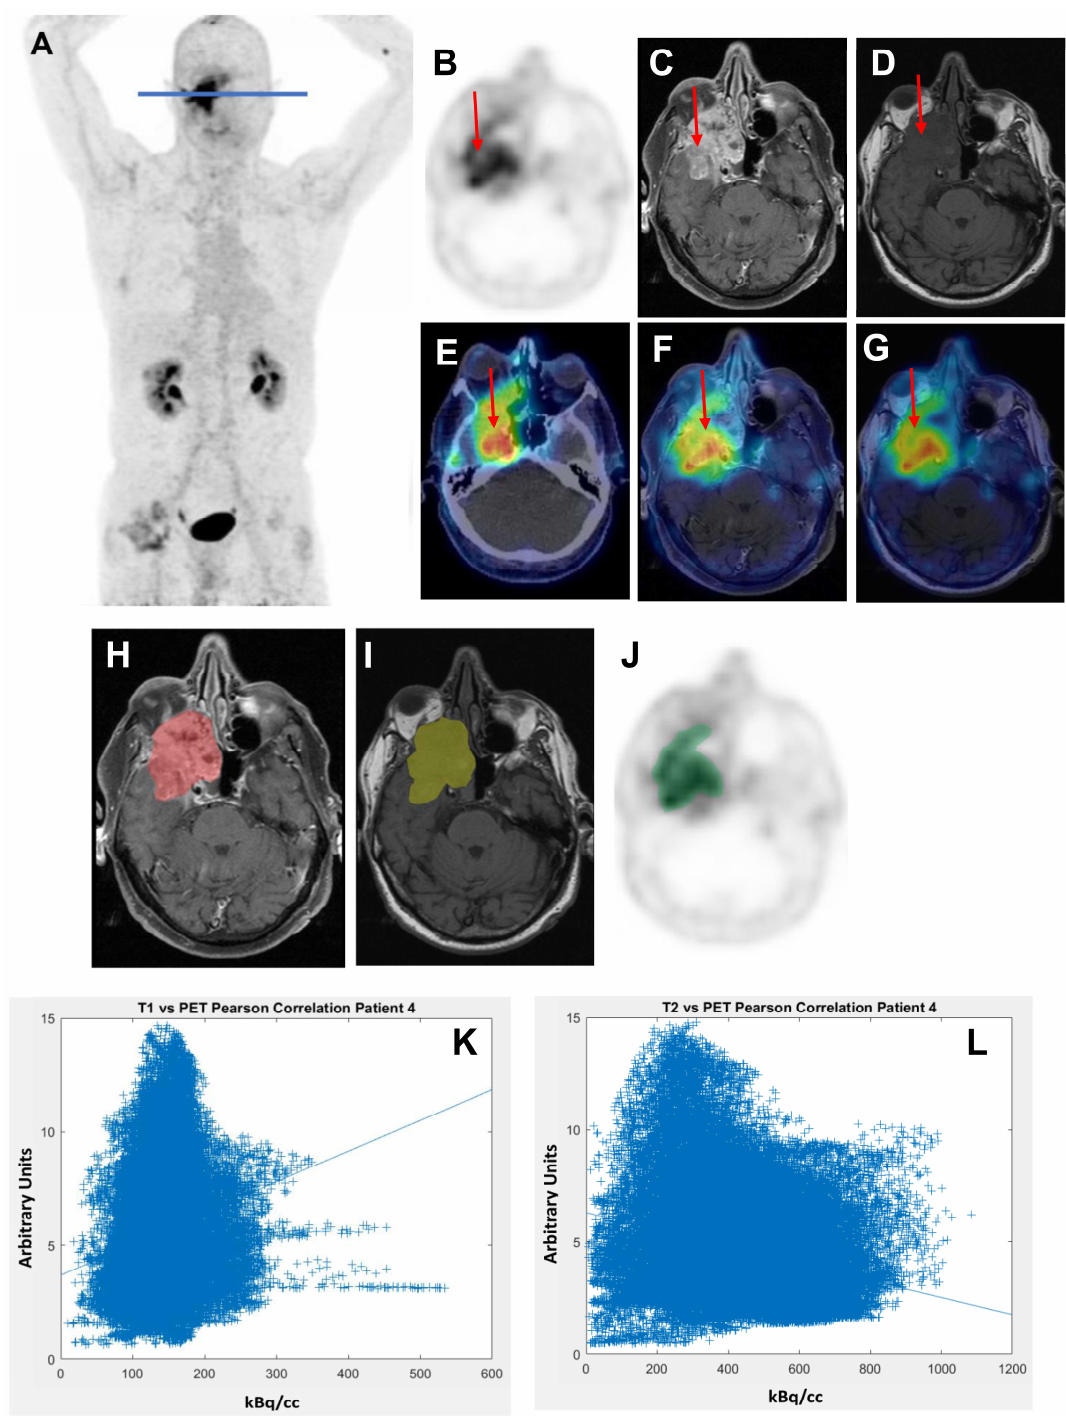
Figure 2. Example (Patient number 4) of a treatment-naïve ACC (tubular type) in the right nasal sinus. ( A ): Maximum Intensity Projection (MIP); ( B – G ): appearance of the tumour in different imaging modalities: ( B ): 68 Ga-FAPI PET, ( C ): MRI (ceT1w); ( D ): MRI (T2w); ( E ): 68 Ga-FAPI PET fused with CT; ( F ): 68 Ga-FAPI PET fused with ceT1w MRI, ( G ): 68 Ga-FAPI PET fused with T2w MRI. Red arrows in B–G point at the tumour. ( H – J ): Manual tumour delineation based on ( H ): ceT1w MRI (tumour delineation in red), ( I ): T2w MRI (tumour delineation in yellow) and ( J ): 68 Ga-FAPI PET (tumour delineation in green). ( K ): ceT1w correlation scatter plot at 60 min; ( L ): T2w correlation scatter plot at 60